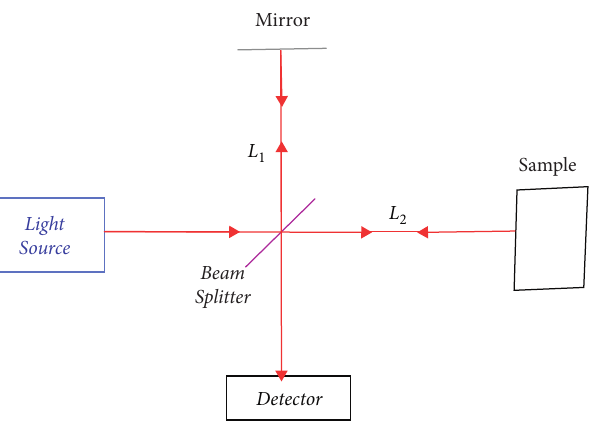
Figure 2: Schematic of OCT in Michelson interferometer.